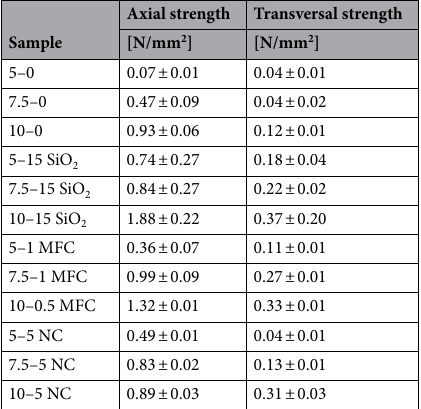
Table 1. Values of the compressive strengths in both directions (axial and transversal) with different amounts of PVA and the maximal degree of filling for all filler